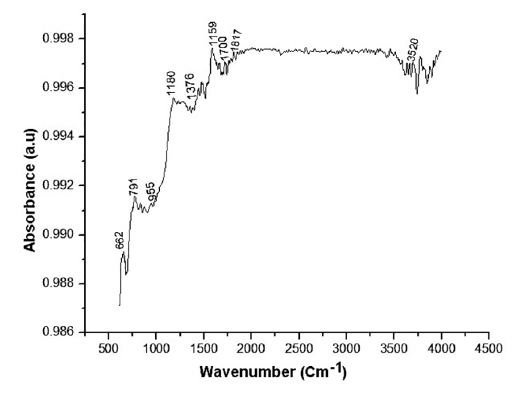
O (x=10 % and x 1 = 0.5 %) doped 2 5